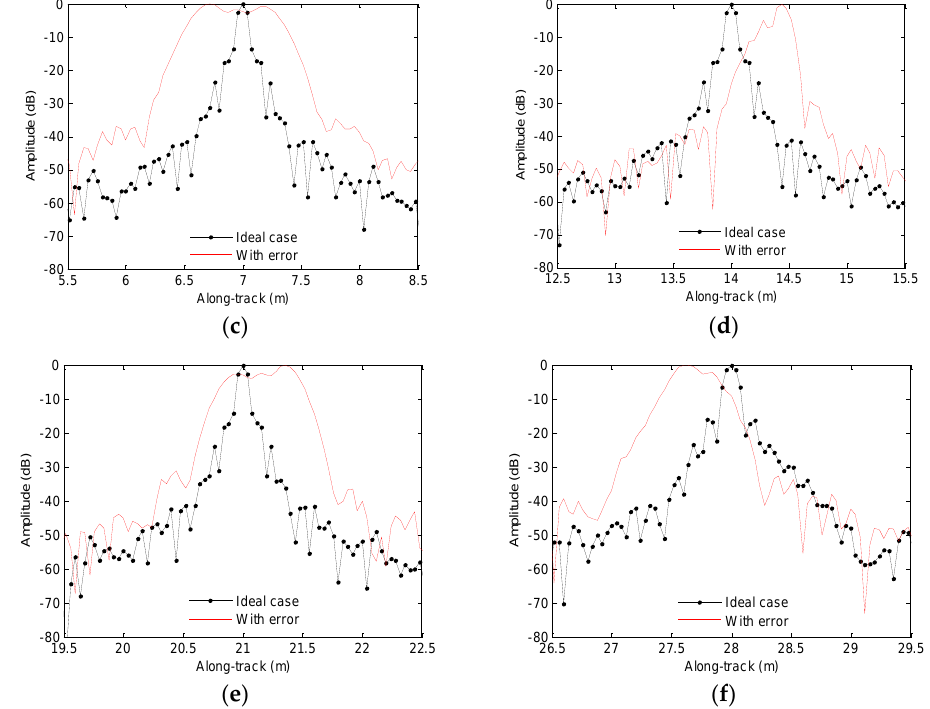
Figure 13. Processing results with sinusoidal heave: ( a ) imaging result; ( b ) slice of T1; ( c ) slice of T2; ( d ) slice of T3; ( e ) slice of T4; ( f ) slice of T5. Table 3. Quality parameters with heave.